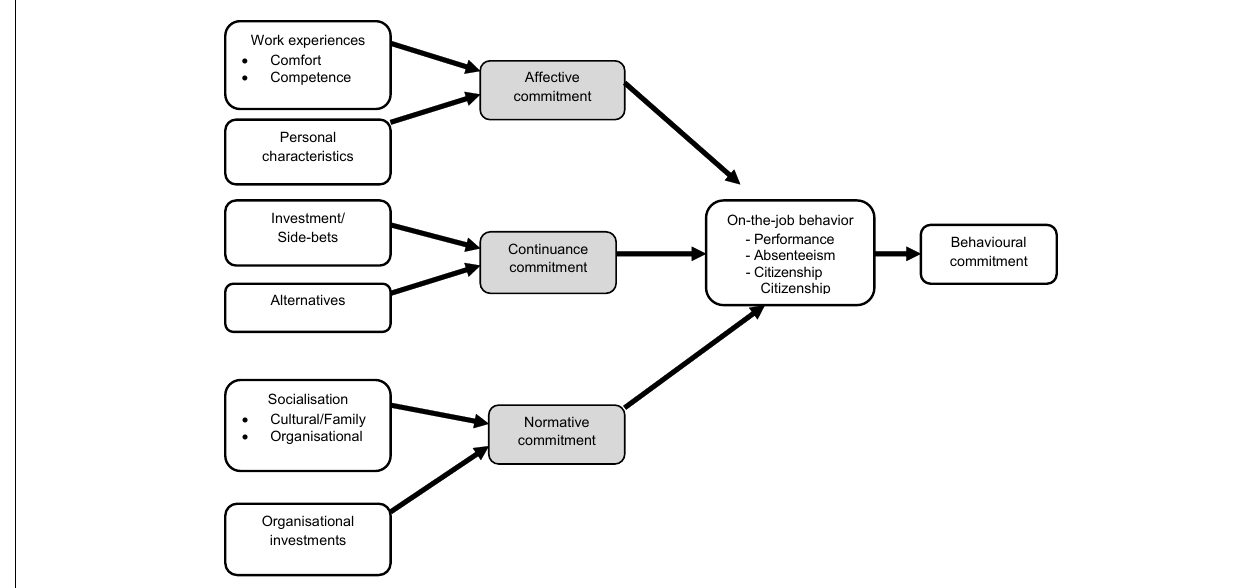
FIGURE 2 A three-component model of organisational